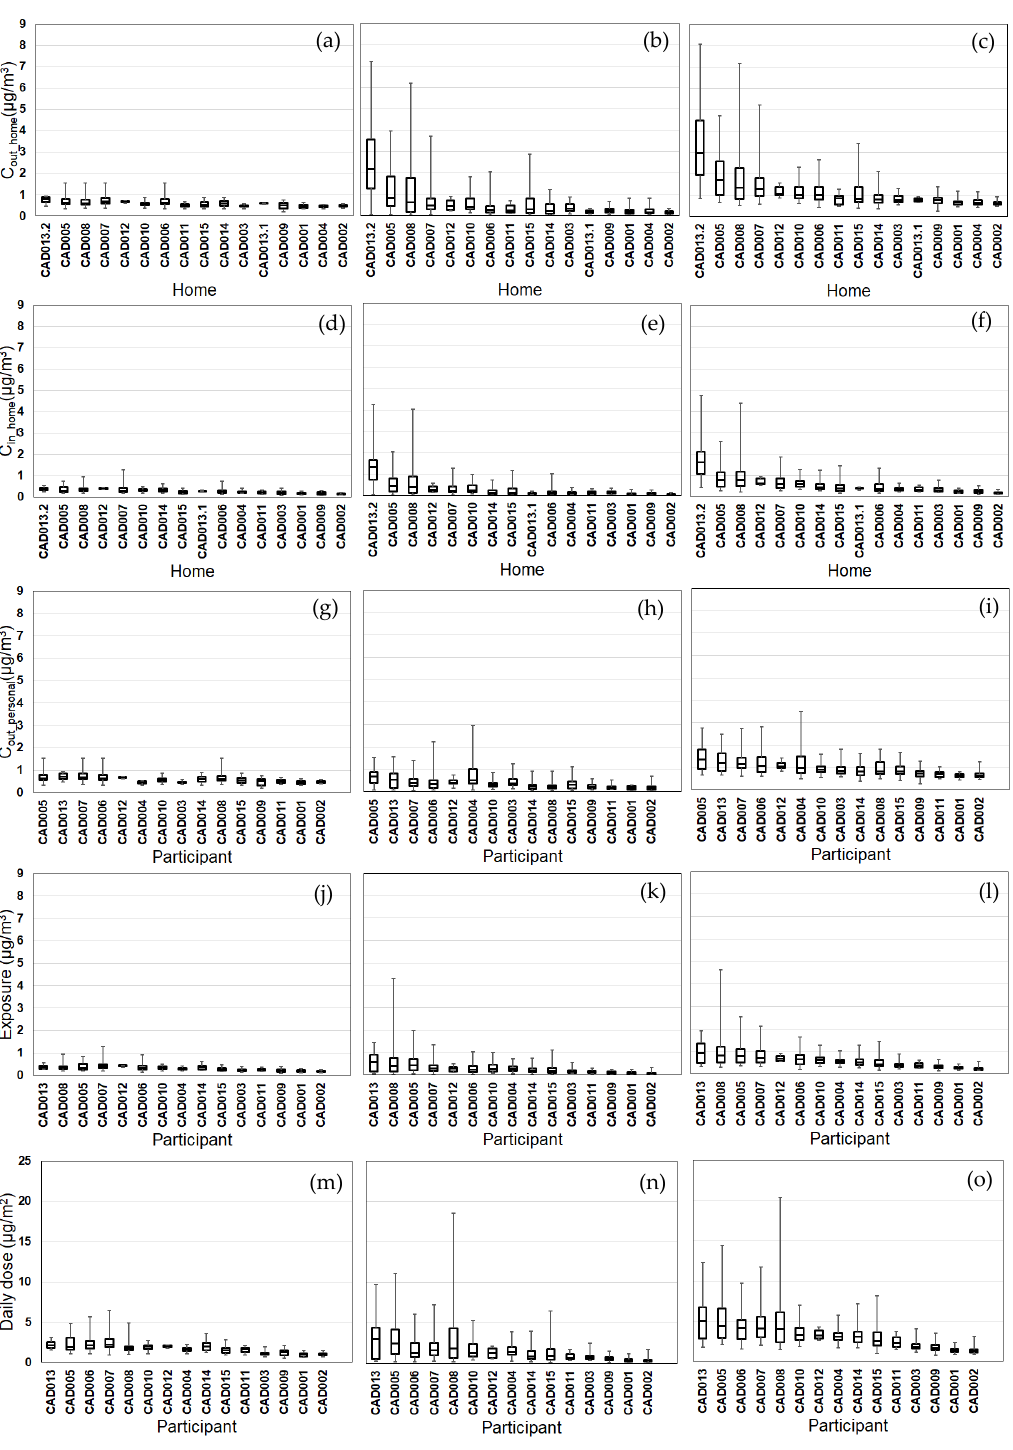
Figure 3. Modeled EC exposure metrics for Tier 1 (outdoor home concentrations; a–c ), Tier 2 (indoor home concentrations; d – f ), Tier 3 (personal outdoor concentrations; g – i ), Tier 4 (exposures; j – l ), Tier 5 (inhaled dose; m – o ) from background ( a , d , g , j , m ), on-road vehicle emissions ( b , e , h , k , n ), and total EC ( c , f , i , l , o ). Results (24 h average, 08:00–08:00) are sorted by total EC median values from highest to lowest. Shown are medians with 25th and 75th percentiles, and whiskers for minimum and maximum